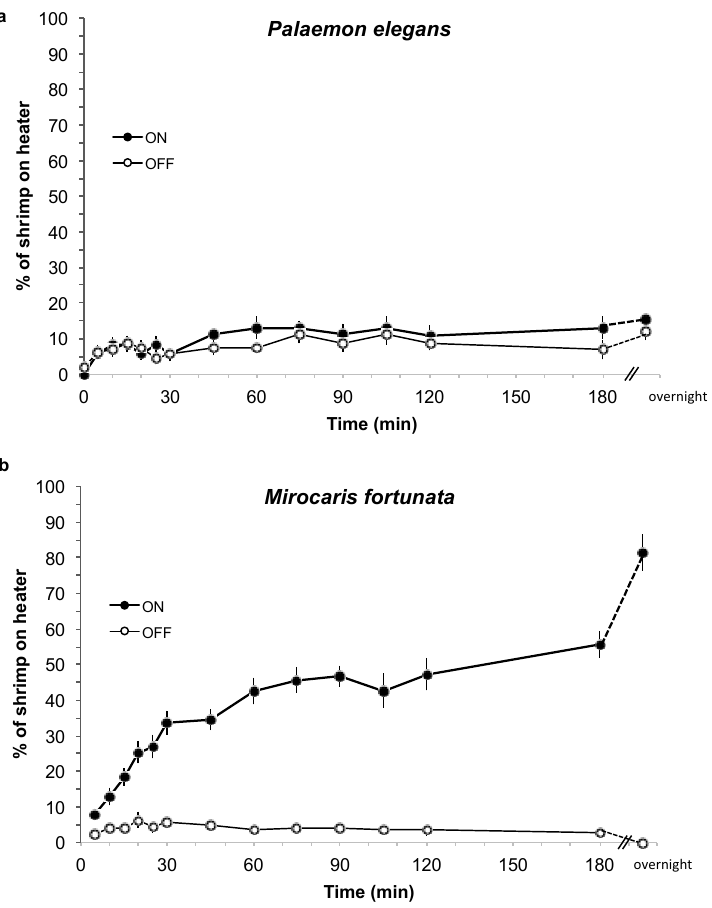
Figure 13. Two-choice experiment (on vs off heating thermostats) on Mirocaris fortunata and Palaemon elegans . Distribution of M. fortunata ( a ) and P. elegans ( b ) on the on and off thermostats over time. Two batches of 28 and 19 M. fortunata were tested 6 times each ( n = 12 replicas per point, except overnight, n = 4 replicas). Two batches of 20 P. elegans were tested 4 times each ( n = 8 replicas per point, except overnight, n = 4 replicas). The thermostats either on (set to 25 °C) or off were introduced on each side of the rearing tank (9 °C) in the upper region. The shrimp were observed for 30 min. The on and off thermostats were inverted between two consecutive trials. The distribution is presented as mean % individuals (± S.E.M.) on each thermostat.